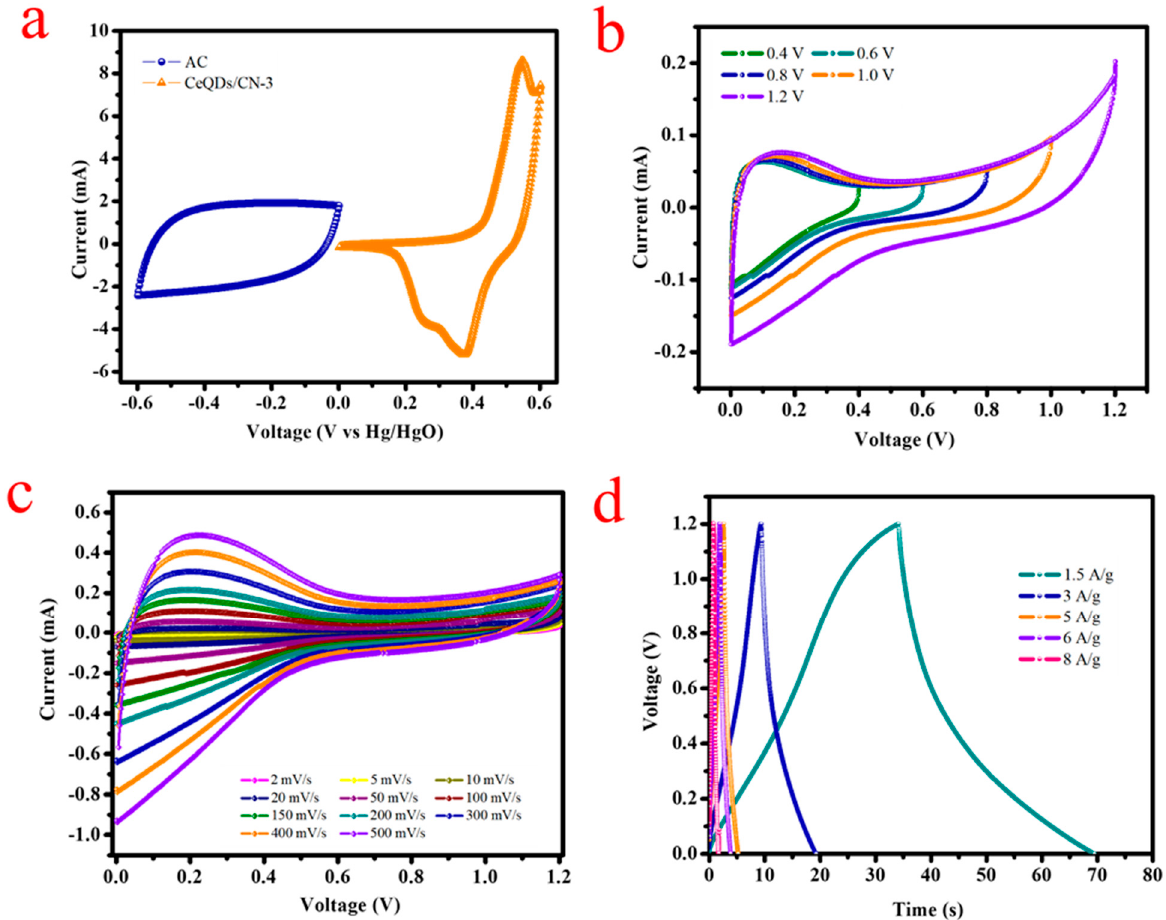
Figure 7. Electrochemical performance of the CN/CeQDs-3//AC HCASD device: ( a ) comparison of the CV curves of AC and CN/CeQDs-3 using three-electrode configuration at 20 mV/s; ( b ) CV curves of HCASD at different potentials; ( c ) CV profiles at different scan rates with a potential window of 1.2 V; ( d ) GCD profiles with different current densities of HCASD